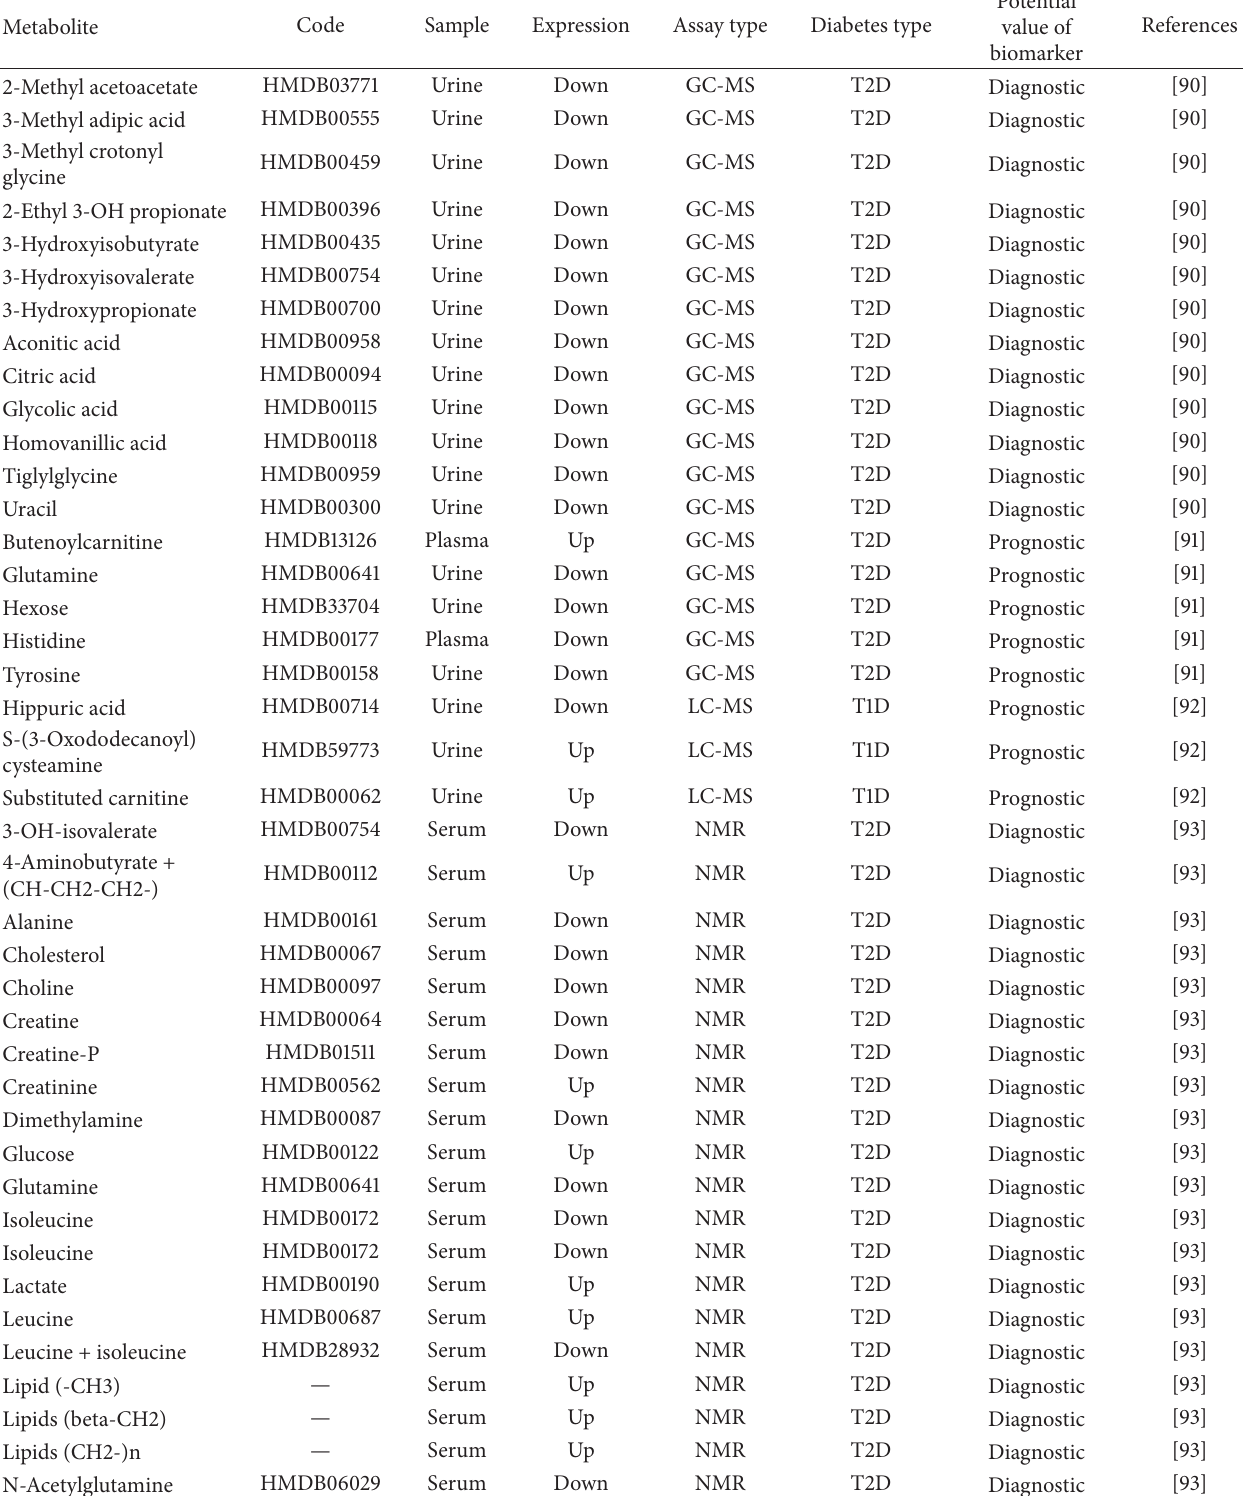
Table 6: Metabolomics biomarkers. List of significant metabolites ordered as they are cited in the text. LC/MS/MS: liquid chromatography coupled to tandem mass spectrometry; GC-MS: gas chromatography/mass spectrometry; NMR: Nuclear Magnetic Resonance;